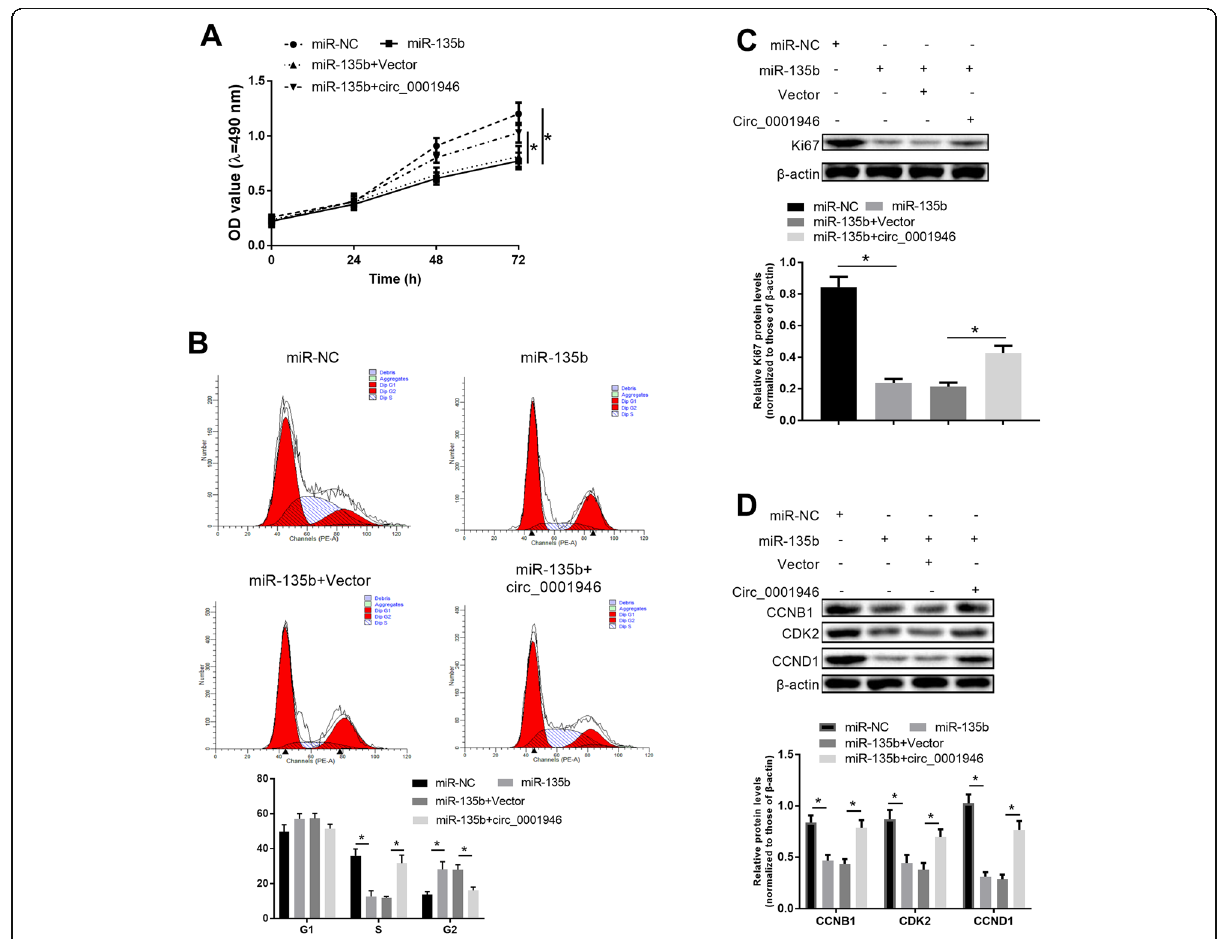
Fig. 3 Hsa_circ_001946 promoted proliferation and cell cycle progression by sponging miR-135b in T-HESCs. Cells were overexpressed with hsa_circ_001946 and/or miR-135b. a. MTT for proliferation. b. Flow cytometry for cell cycle. c and d . Western blot assays for detecting the expression of Ki67, CCNB1, CDK2, and CCND1. * P <